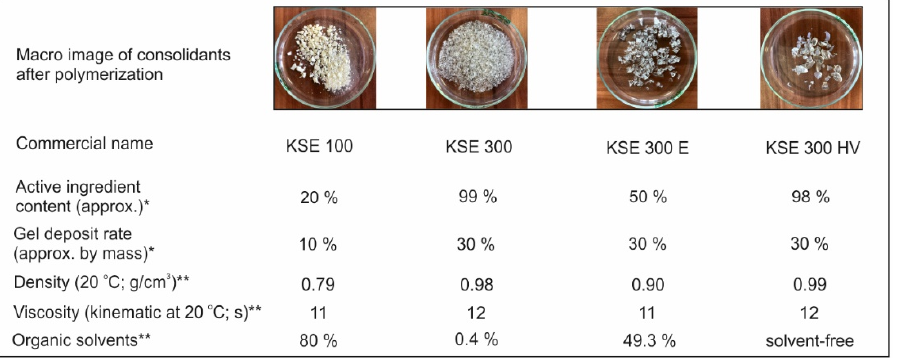
Figure 4. Consolidate agent properties according to the manufacturer (* data from Remmers technical datasheets; ** data from Safety data sheet). Table 1. Composition of the tested consolidants according to safety data sheets from producer (Rem- mers Gmbh).